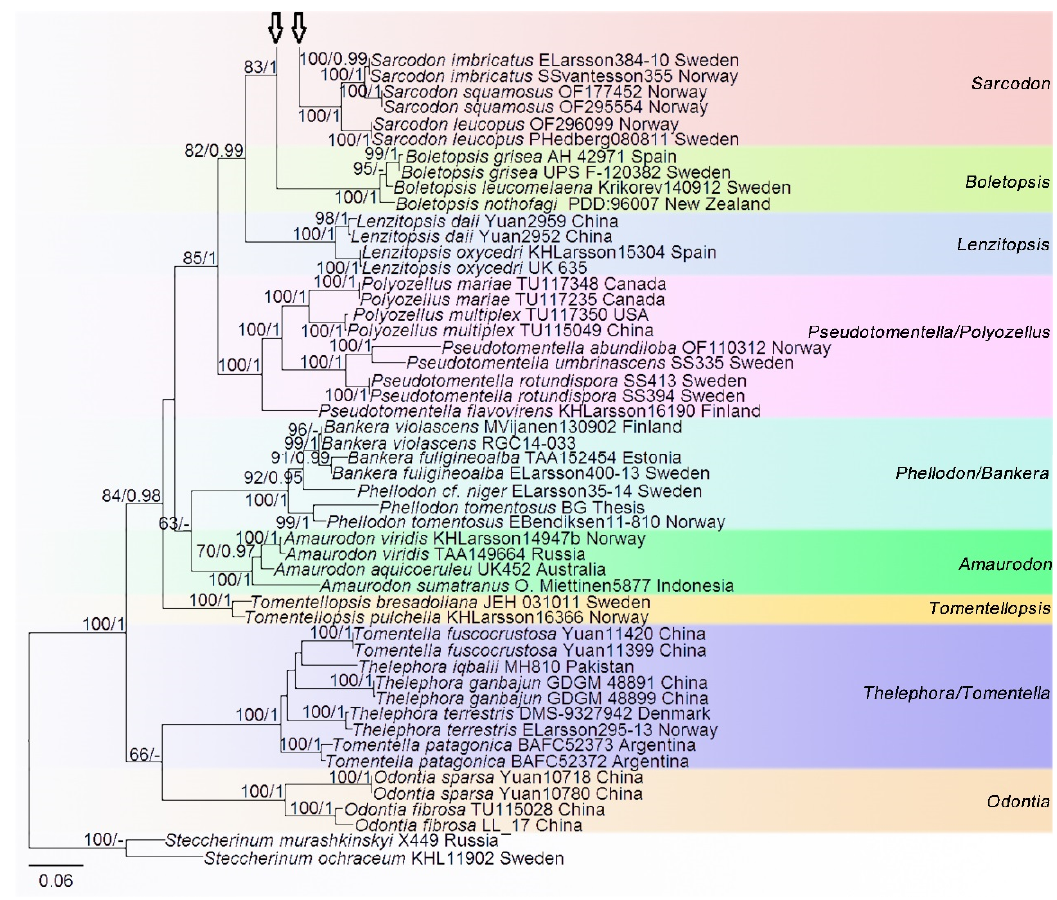
Figure 2. Maximum likelihood phylogenetic analysis based on the nLSU and ITS sequences of Thelephorales. Branches are labeled with maximum likelihood bootstrap support greater than 50 % and Bayesian posterior probabilities greater than 0.95. Newly sequenced collections are in bold.